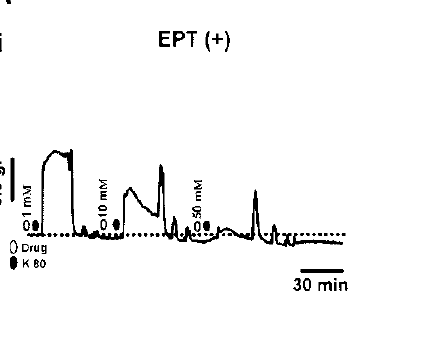
2.2. Inhibitory Effects of trans-Caryophyllene on Contractions Induced by High-K + in Isolated Rat Trachea with or without Epithelium